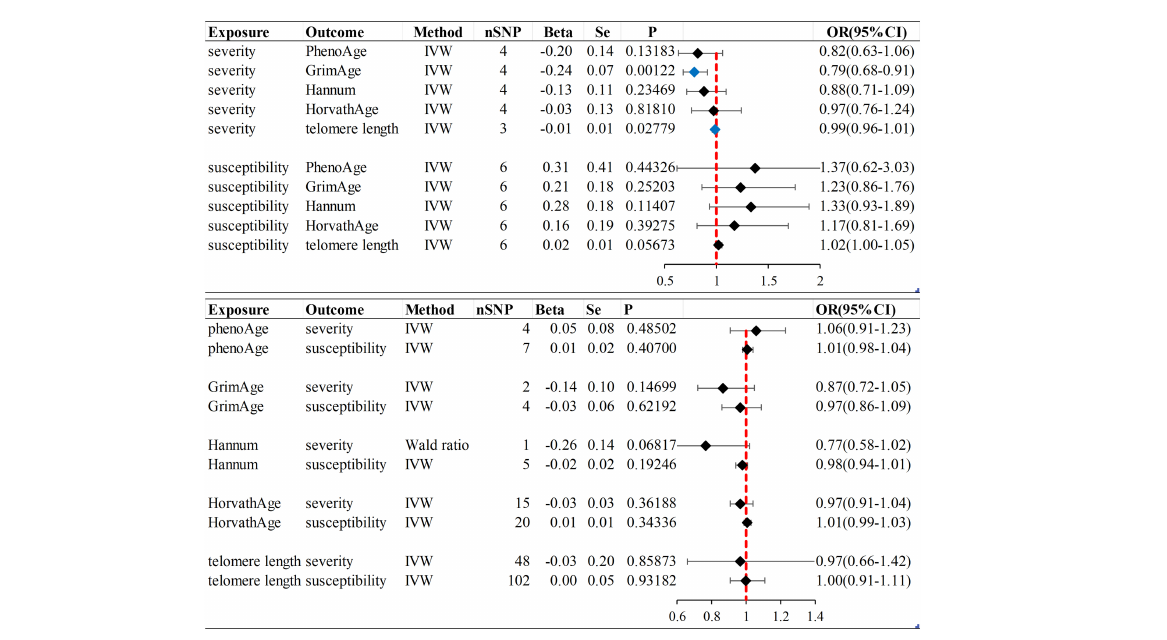
FIGURE2 Inverse variance weighted (IVW) method was used as the main method to analyze the causal association between aging and susceptibility and severity of COVID-19. Aging is based on epigenetic age (PhenoAge, GrimAge, Hannum, HorvathAge) and telomere length as biological indicators. Beta: risk index; Se: standard error; OR (95% CI): odds ratio (95% confidence interval); Forest plot: Visualize the causal effect of exposure on the risk of outcome by IVW method [The standard line is the line of “X = 1” (red dashed line)], The blue marker dot is a positive result of P <